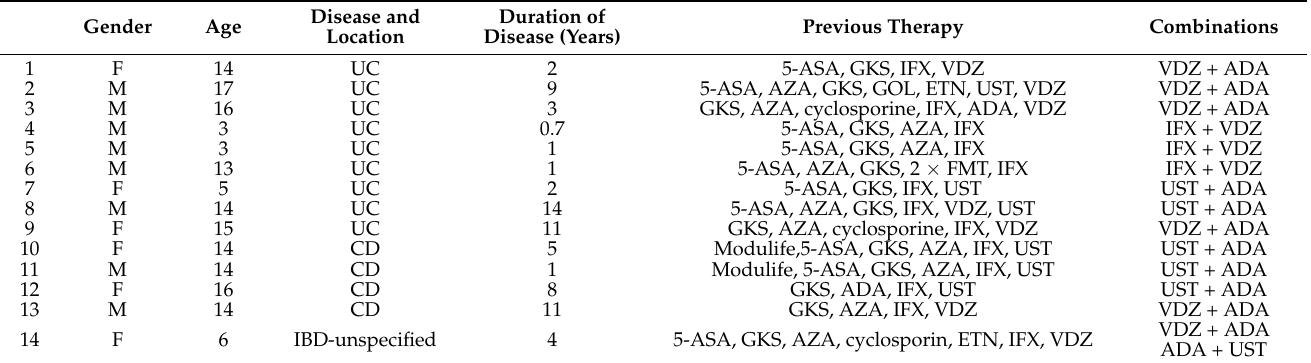
Table 1. Characteristics of patients qualified for dual biological therapy-baseline